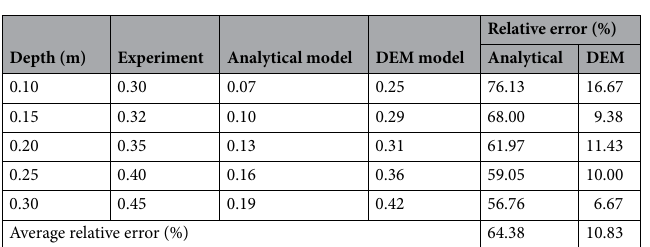
Table 6. Dimensions of the furrow width (Wf) formed after the passage of the subsoiler at a speed of 2.5 km/h.